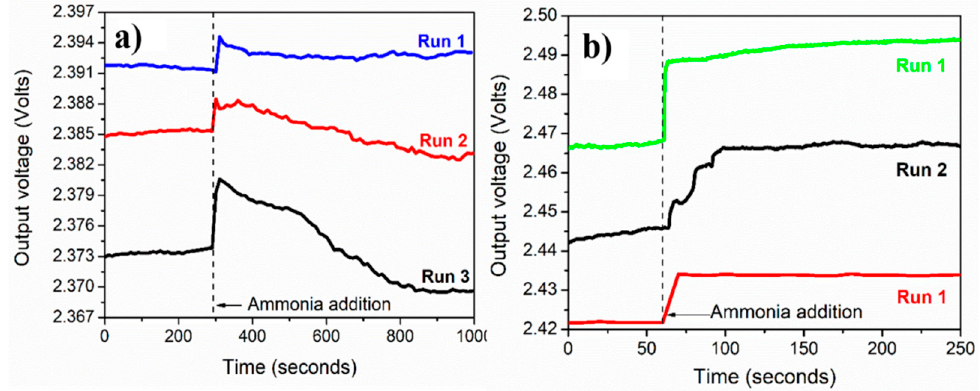
Figure 7. Repeatability: variation of output voltage with time for PVP capped Ag-NPs synthesized by using ( a ) cold and ( b ) polyol synthesis methods (recorded for 3 cycles and at ammonium solution concentration = 2 M).